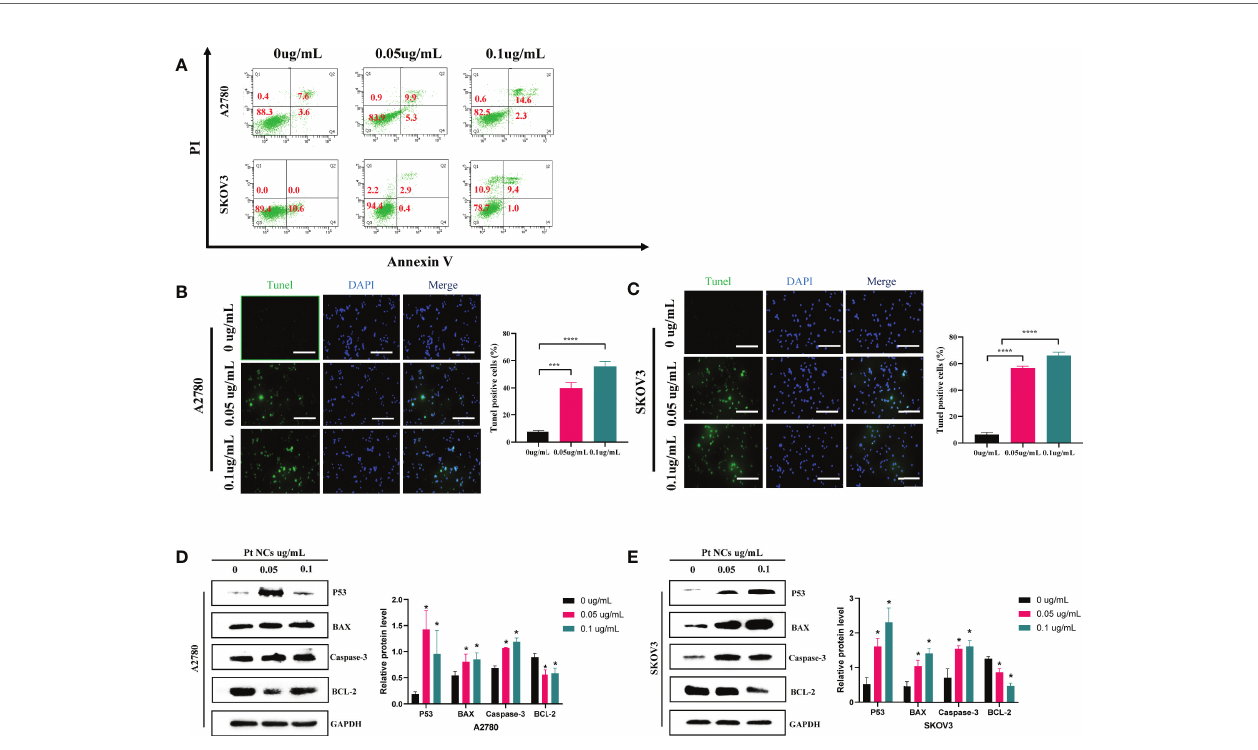
FIGURE 4 | Induction of apoptosis by PEI-Pt NCs in A2780 cells and SKOV3 cells. (A) Characteristic fl uorescence dot plots showing fl uorescence-activated cell sorting (FACS) analysis by membrane-linked protein V staining and PI to determine the cell death status of PEI-Pt NCs after co-incubation at different concentrations (0ug/mL, 0.05ug/mL, 0.1ug/mL) for 4 h. Q2 and Q4 regions represent apoptotic cells. The Q1 region represents cells that have died. The Q3 region represents cells that are alive. (B) Tunel apoptosis immuno fl uorescence staining of cells treated with different concentrations (0ug/mL, 0.05ug/mL, 0.1ug/mL) of PEI-Pt NCs drug in A2780 cell line for 24h. (C) Tunel apoptosis immuno fl uorescence staining of SKOV3 cell line in different concentrations (0ug/mL, 0.05ug/mL, 0.1ug/mL) of PEI-Pt NCs drug-treated cells for 24h. Tunel staining is green, DAPI nuclear staining is blue, and Merge is the merged image. Histograms were calculated for the ratio of apoptotic cells. (*p < 0.05, ***p < 0.001, ****p < 0.0001) (D) Histogram of WB results of apoptosis-related genes P53, BAX, Caspase-3 and BCL-2 in A2780 cell line in different concentrations of PEI-Pt NCs drug treatment groups. (E) Histogram of WB results of apoptosis-related genes P53, BAX, Caspase-3 and BCL-2 in SKOV3 cell line in different concentrations of PEI-Pt NCs drug treatment groups. * indicates statistical signi fi